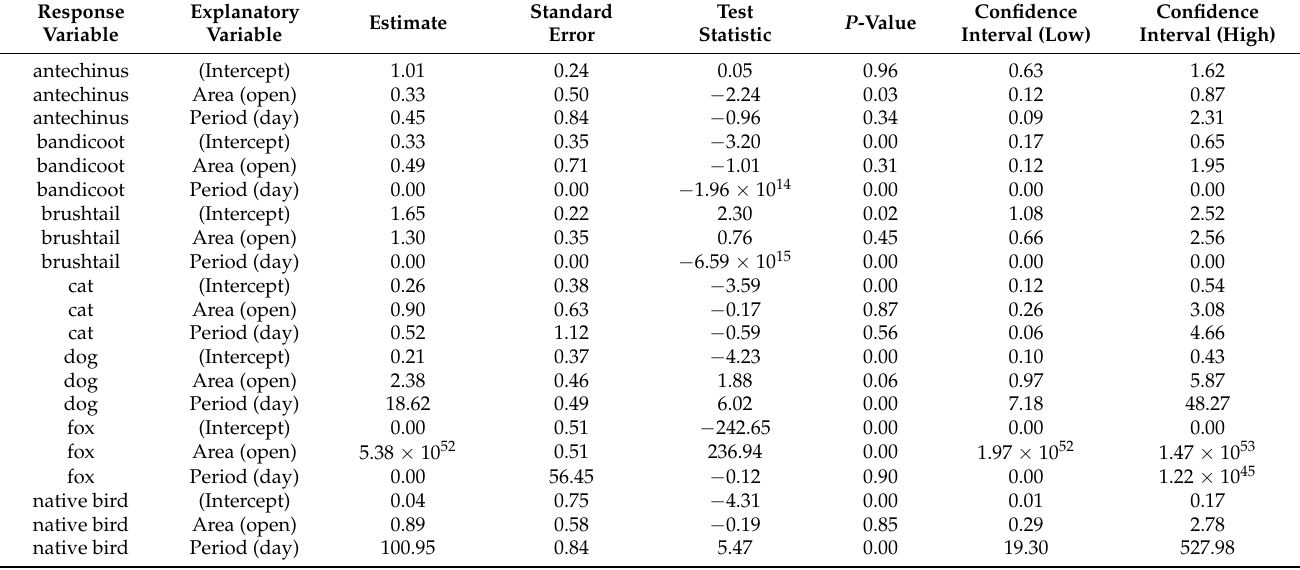
Table 3. Multinomial logistic regression results for each animal species/group detected by motion-sensor cameras, analysed against period (day/night) and habitat